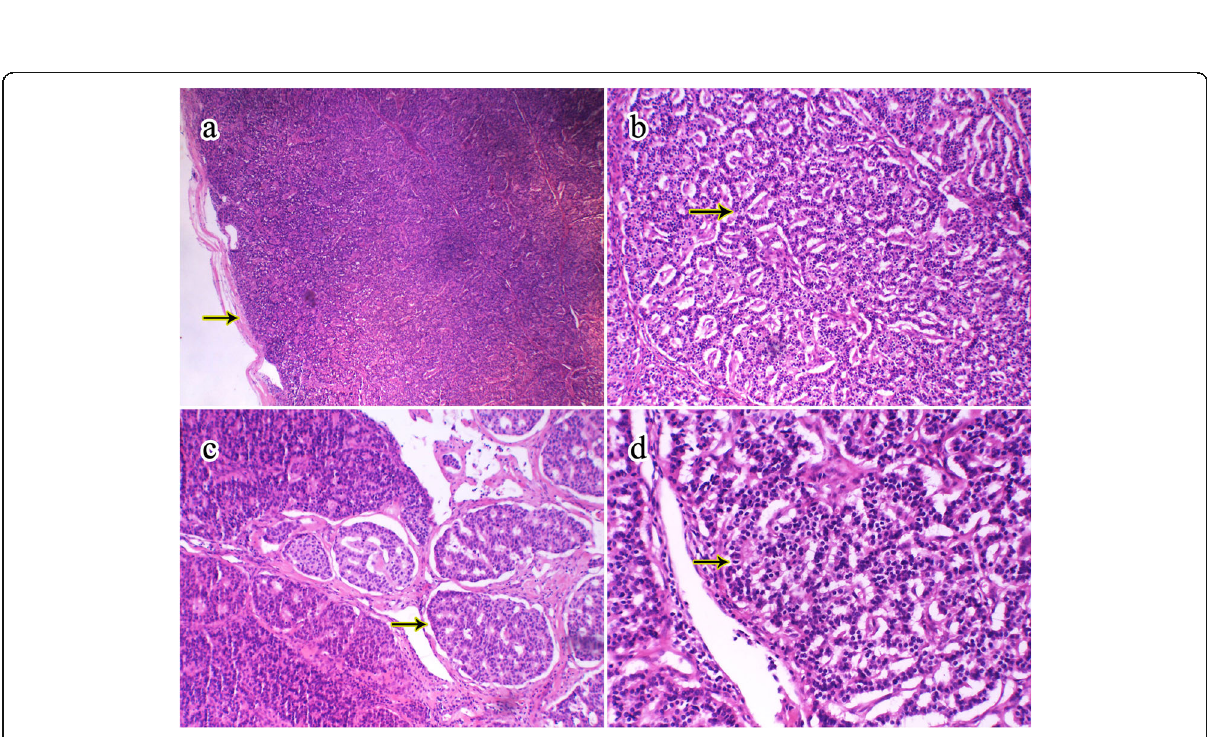
Fig. 1 a Echocardiography showed a homogeneous mass in the left ventricle (the yellow arrow). b, c Magnetic resonance imaging (MRI) showed a longer T2 signal of the left ventricular mass (the yellow arrow). d MRI demonstrating round mass with clear boundary in left ventricle (the yellow